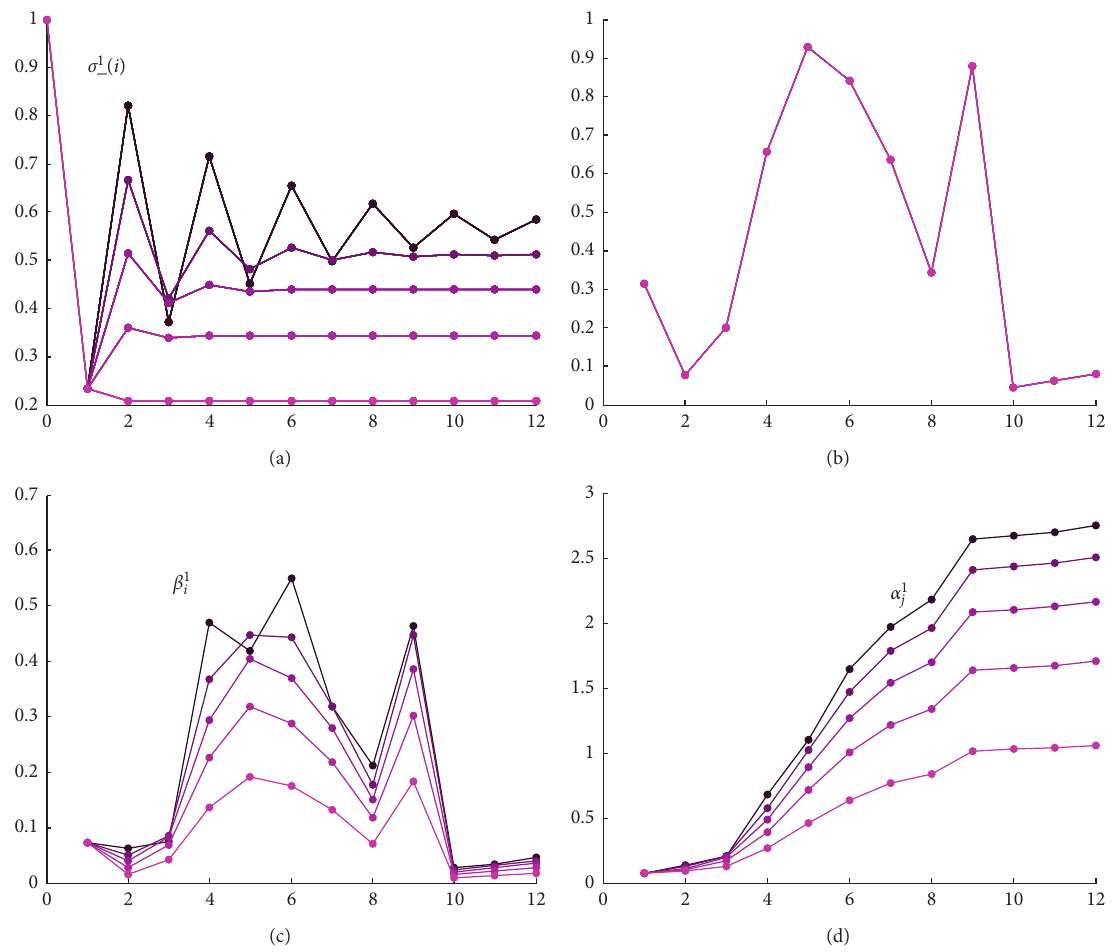
Figure 1: Graphs for a simulation of five scenarios for 12 months. The union of the values by means of lines is only for monitoring purposes. (a) Values of σ − ( i ) for a period of twelve months; (b) factor of proportion ξ i ; (c) β i for five probable states of loss of control; (d) accumulation factor α j